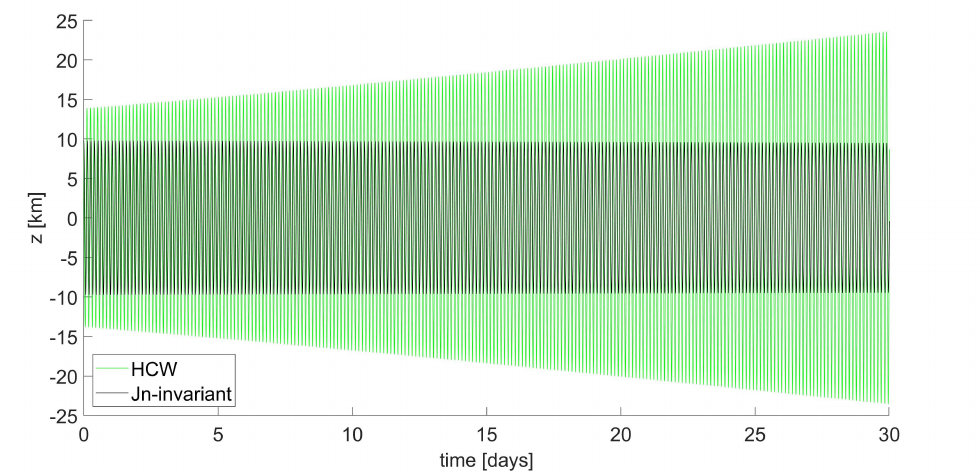
Figure 7. Mid-inclination LEO formation: time behavior of y component.